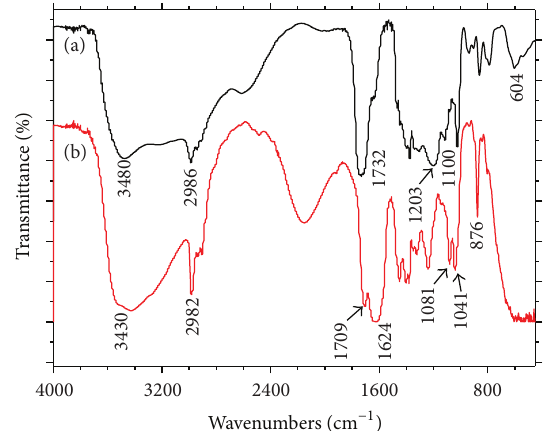
Figure 5: FT-IR spectra of Et 2 Cit and its complex CaEt 2 Cit: (a) Et 2 Cit and (b) CaEt 2